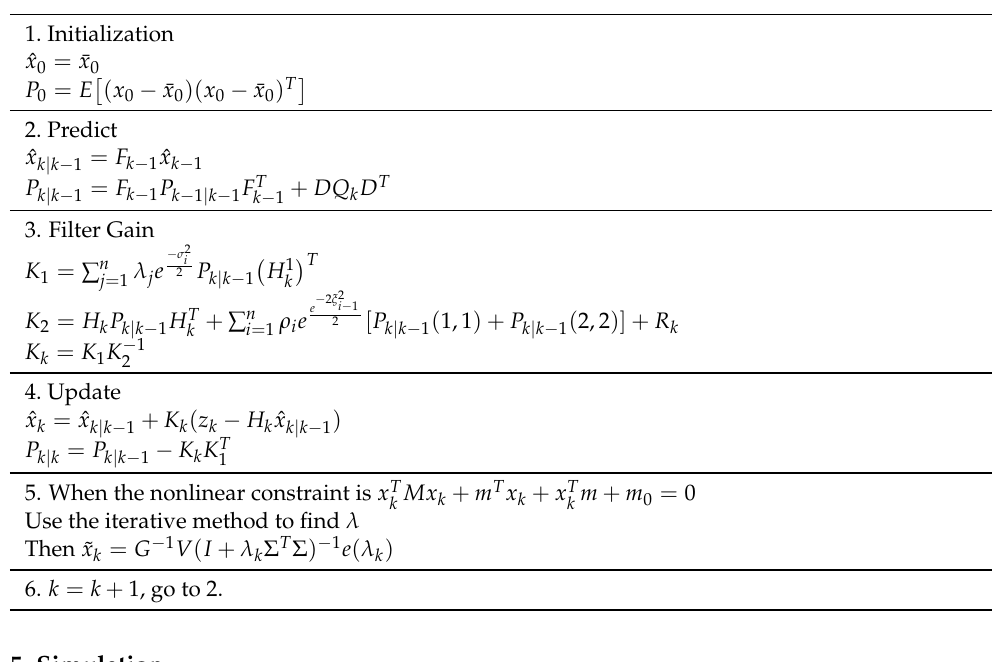
Table 3. PL-MMSE with Nonlinear Constraints